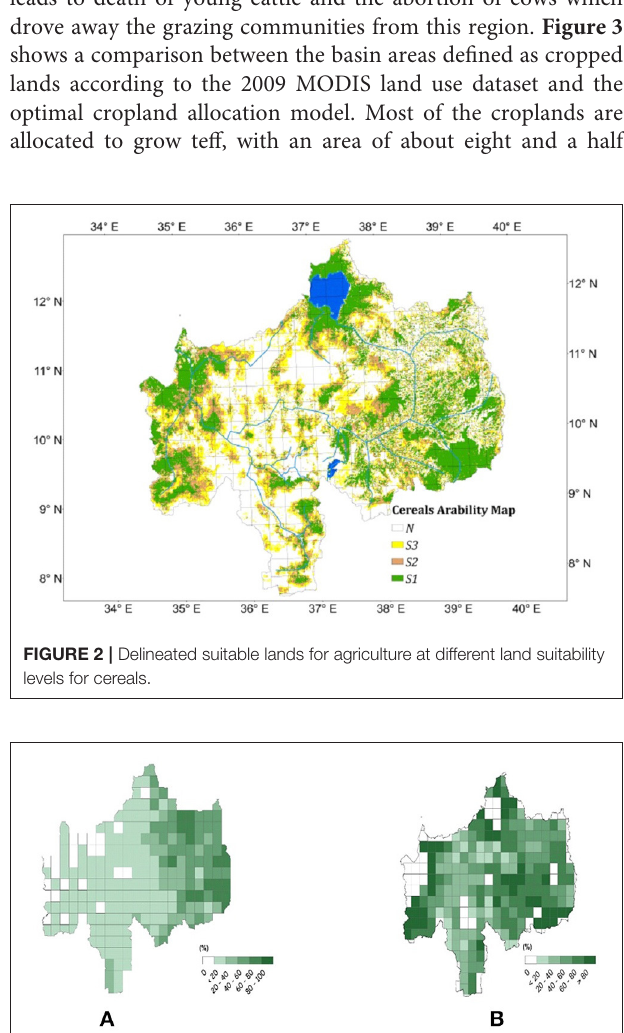
FIGURE 3 | A comparison between (A) the existing cropland using 2009 MODIS land use dataset and (B) the model optimal cropland that maximizes the rain-fed agriculture Net